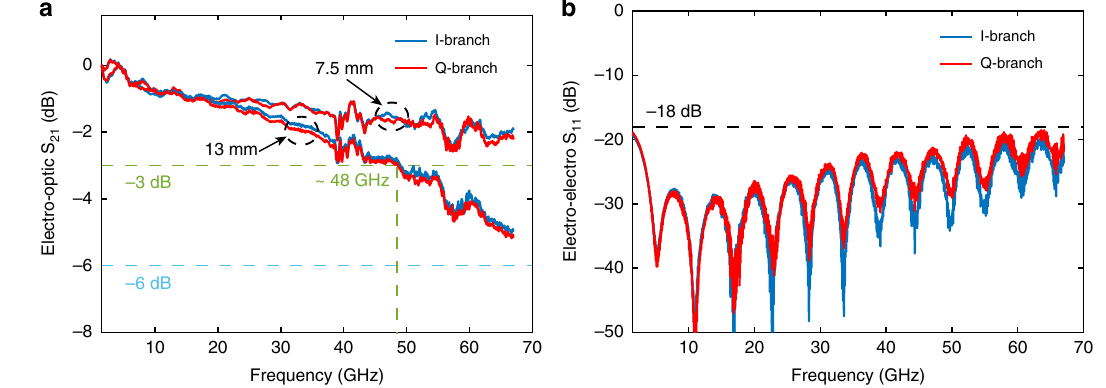
Fig. 4 Small-signal response. a EO bandwidths (S 21 parameter) and b electrical re fl ection S 11 of the 13-mm IQ